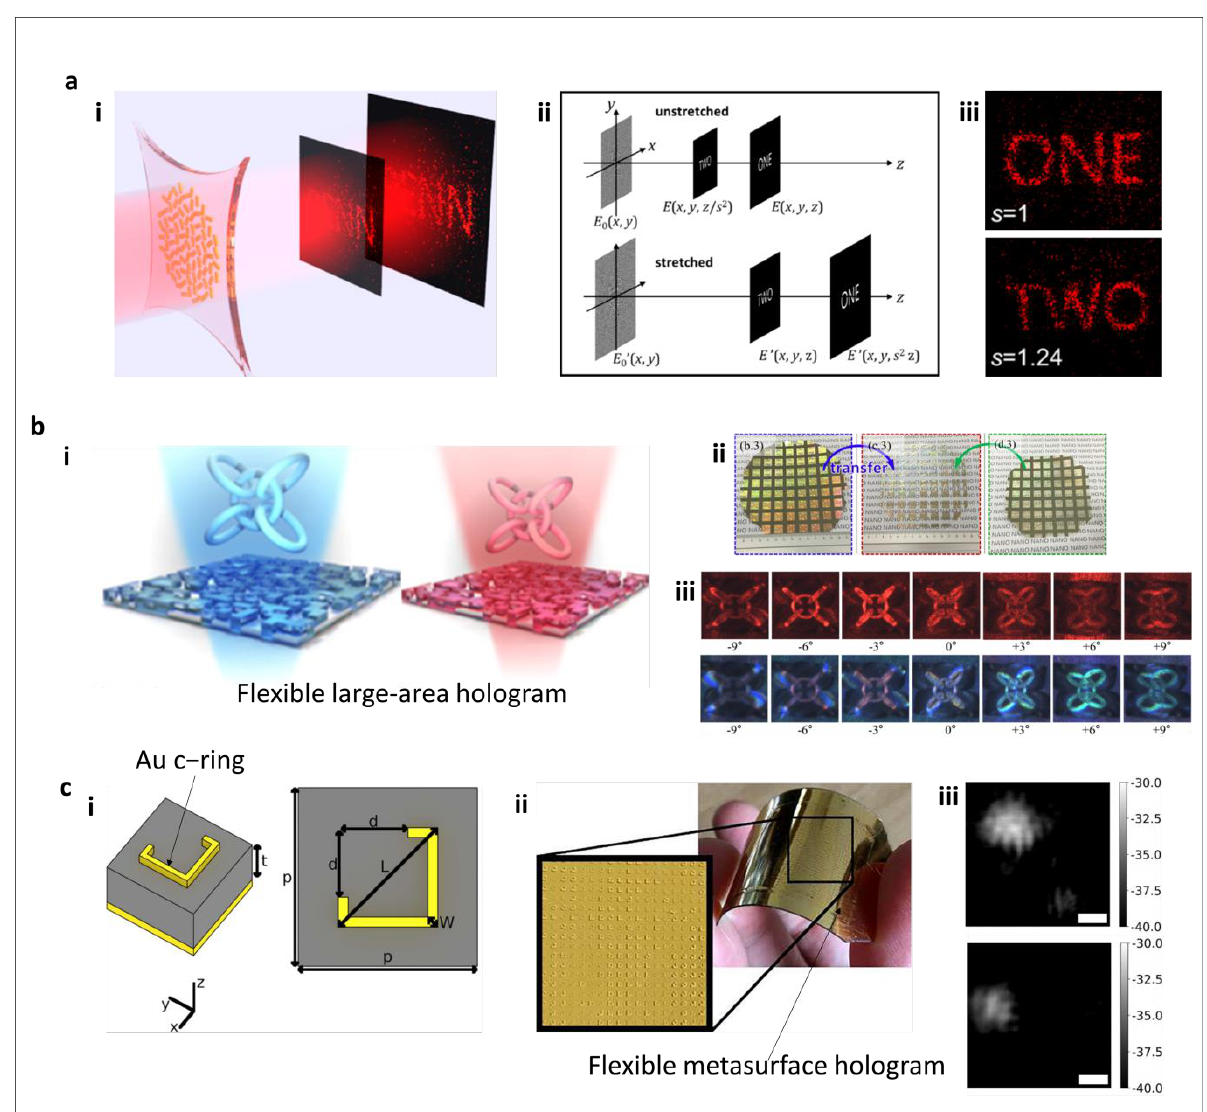
Figure 5. Mechanical tuning of metaholograms. ( ai ) Schematic of the metahologram device based on a deformable substrate with periodically arranged gold nanoarrays. ( aii ) Schematic of the switching mechanism of a two-plane hologram under stretching. A stretch ratio of s moves the images along the z–plane by a factor of s 2 . ( aiii ) Illustration of hologram images of an experimentally demonstrated metasurface with a focal length of 200 [ µ m] ( top ) in the unstretched state and ( bottom ) when stretched by 24%. ( bi ) Schematic representation of the flexible ring hologram for red and blue colors. ( bii ) Images of the fabricated ring hologram on the PET mold ( left ), transferred ring hologram on the PMMA ( center ), and the remaining PET mold ( right ). ( biii ) Illustration of the captured images under red ( top ) and white ( bottom ) light-emitting diodes (LEDs) illumination. The angular spectrum is varied from − 9 to +9 with step size of 3. ( ci ) Illustration of the unit cell of the c–ring meta-atom. ( cii ) An image of the fabricated flexible hologram metasurface. The hologram metasurface exhibits a millimeter operating wavelength range. Inset fully displays the arrangement of the c–ring meta- atoms. The inter-atomic distance between meta-atoms (pitch) is 800 µ m. ( ciii ) Shows the experimental holographic image realization of the hologram metasurface deflected to one side ( top ) and deflected to a corner. ( a ) Reprinted with permission from ref. [114]. Copyright (2017) American Chemical Society. ( b ) Reprinted with permission from ref. [116]. Copyright (2020) American Chemical Society. ( c ) Reprinted with permission from ref. [117]. Copyright (2019) AIP